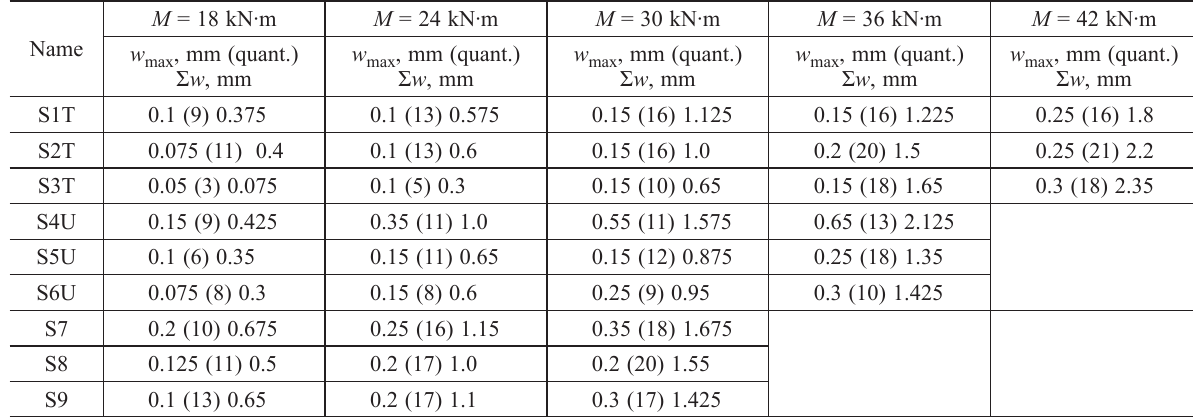
Table 13. Parameters of the cracks from the regions where shear forces act: maximal width, quantity, sum of the cracks width